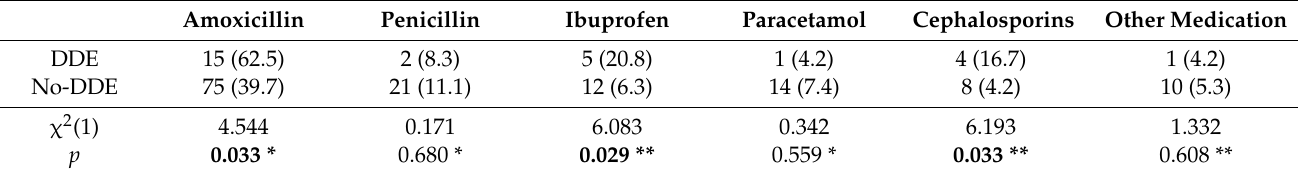
Table 5. Statistical comparisons between DDE and no-DDE groups regarding parameters related to medication administered—N